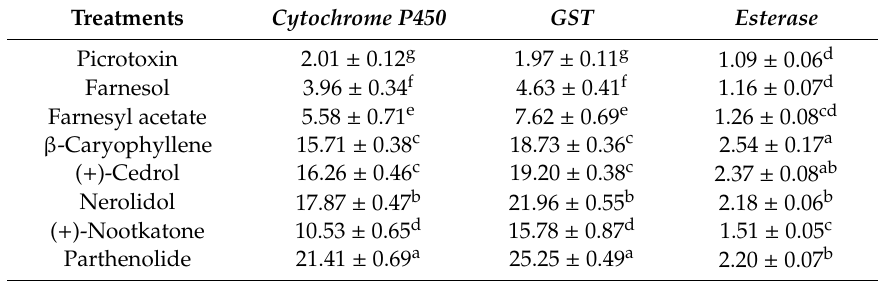
Table 3. Relative fold change in the expression patterns of Rhynchophorus ferruginous detoxification genes in the mid-gut of eighth-instar larvae using quantitative real-time PCR (qRT-PCR). Treatments Cytochrome P450 GST Esterase